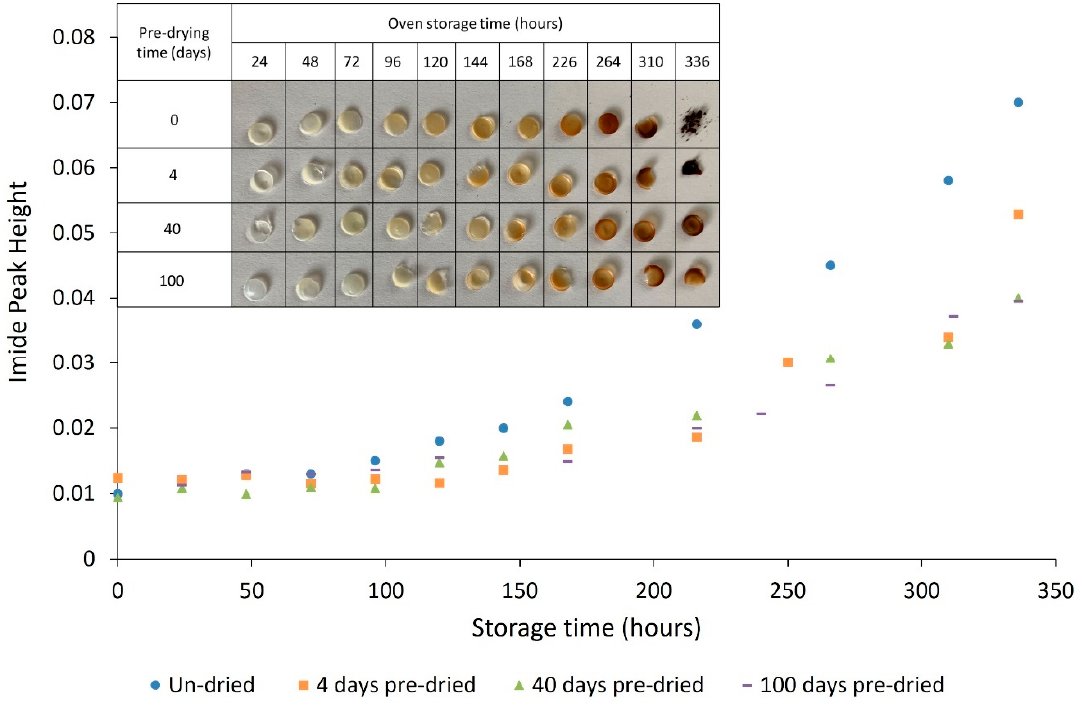
Figure 13. The reduction in melting temperature of PA − 12, as a function of pre-drying time. Changes in T m were calculated from the highest value during oven storage to the final value observed after 336 h.